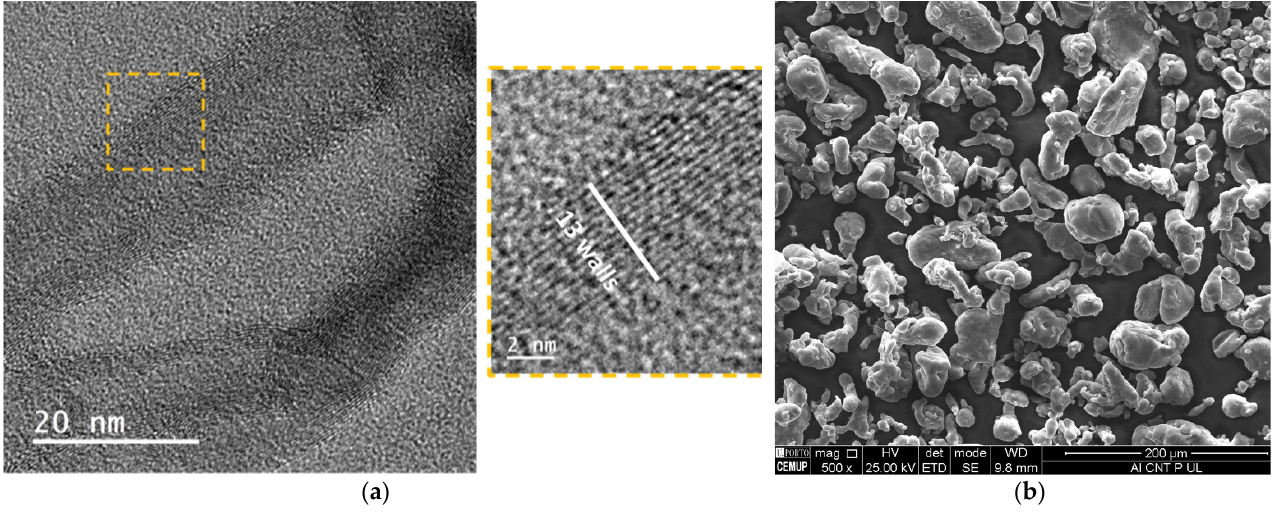
Figure 5. ( a ) HRTEM image of the CNT after ultrasonication showing some structure details and ( b ) SEM image of the Al/CNT mixtures after 15 min ultrasonication. ( b ) SEM image of the Al/CNT mixtures after 15 min